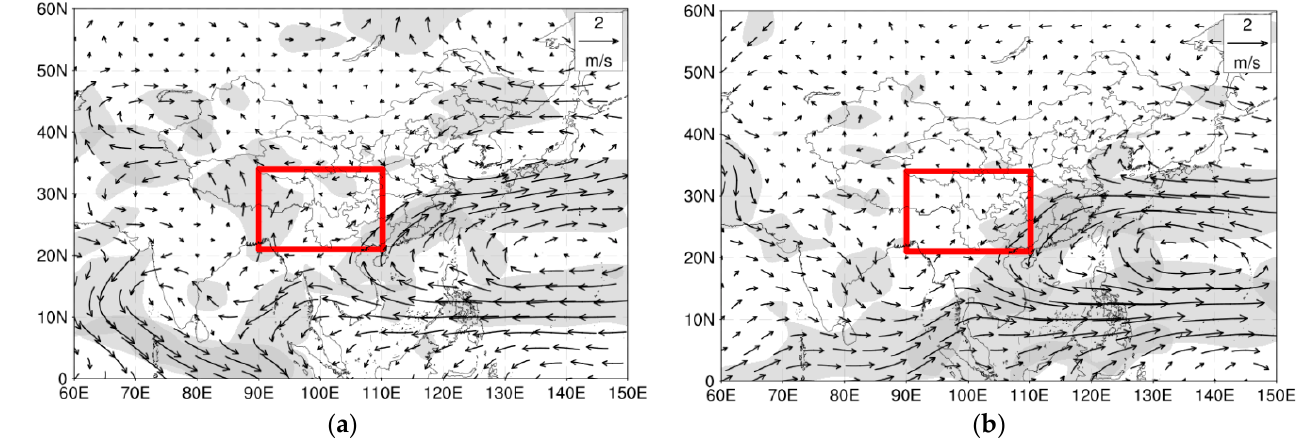
( b ) ( b ) Figure 16. Whole-layer water vapor flux integral and its divergence anomaly in summer of strong and weak East Asian subtropical monsoon surge years. (Unit of water vapor flux integral: